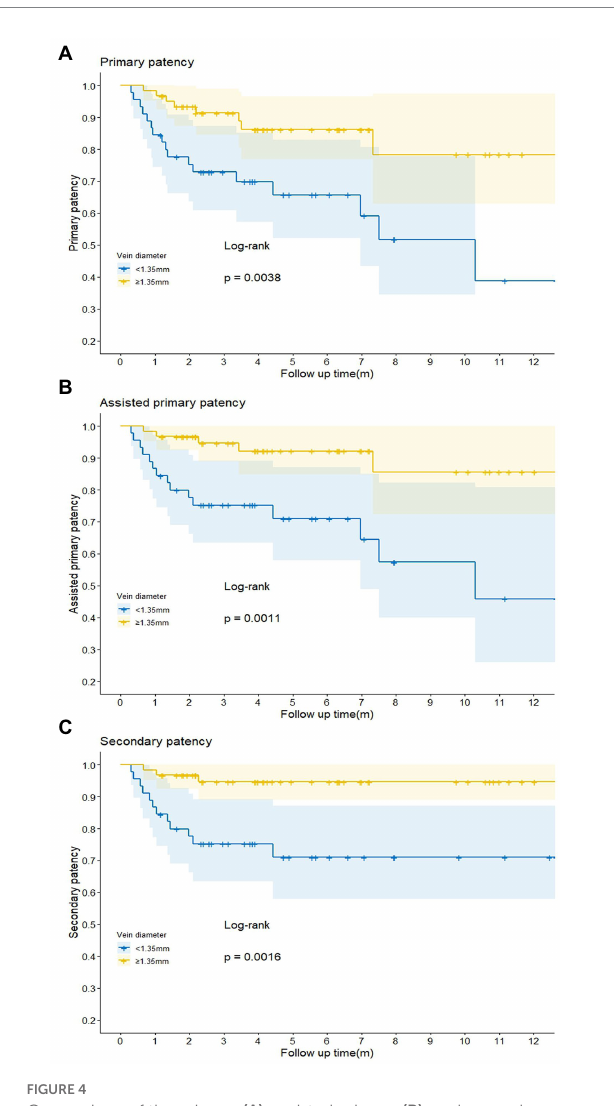
FIGURE 4 Comparison of the primary (A) , assisted primary (B) , and secondary (C) patency rates of the arteriovenous fistula (AVF) in different groups when vein diameter cutoff value was set at 1.35 mm. p < 0.05 was considered statistically